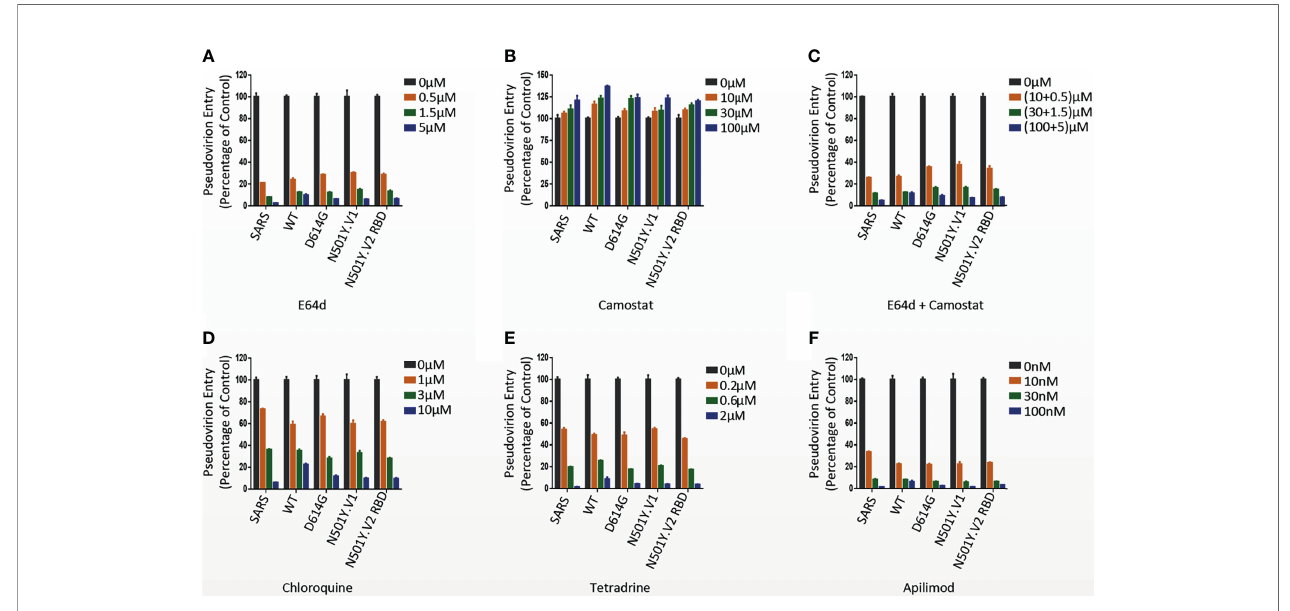
FIGURE 5 | Effects of endocytosis and protease inhibitors on pseudovirion entry. (A – C) N501Y.V1 and N501Y.V2 RBD entry into host cells through CatB/L or TMPRSS2 activation was evaluated by adding E64d, Camostat or the combination of them (E64d + Camostat) to 293T-hACE2 cells 2 h prior to transduction. The luciferase activity was measured 24 h post transduction. (D – F) Inhibition of entry of SARS-CoV, SARS-CoV-2 WT, D614G, N501Y.V1 and N501Y.V2 RBD by adding endocytosis inhibitors Chloroquine, Tetradeine, and Apilimod to 293T-hACE2 cells 2 h prior to transduction. Experiments were done in 4 replicates and repeated at least twice. One representative is shown with error bars indicating